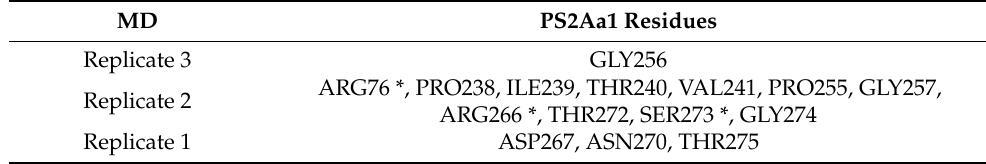
Table 5. Prevalence of PS2Aa1 residues among MD replicates.